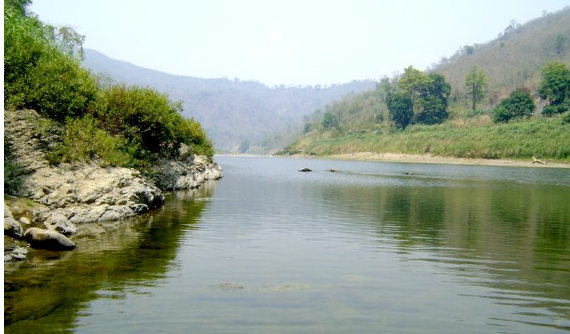
fin hyaline with a row of elongated black marks. Pectoral, pelvic and anal fins golden yellow with hyaline distal margins. Caudal fin edged with black, faintly yellowish-green at the base. In 10% formalin, body creamy, slightly dark dorsally. Dorsal fin hyaline with a row of elongated black marks. Caudal fin hyaline, edged with black. Pectoral, anal and ventral fins hyaline without dark bands.